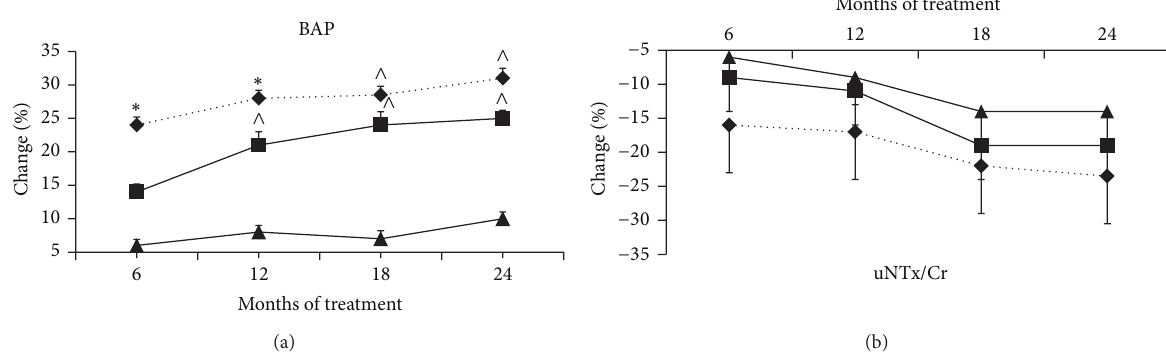
Figure 2: Changes in serum levels of BAP and uNTx/Cr throughout 24 months of treatment. Note: data are means ± SD. BAP: bone-specific alkaline phosphatase; uNTx/Cr: urine N-telopeptide of type 1 collagen/creatinine; ∗ : 𝑃 < 0.05 versus baseline, groups B and C; ∧ : 𝑃 < 0.05 versus baseline and group C. ⧫ : group A, the standard-dose TU group; ◼ : group B, the low-dose TU group; 󳵳 : group C, placebo group.